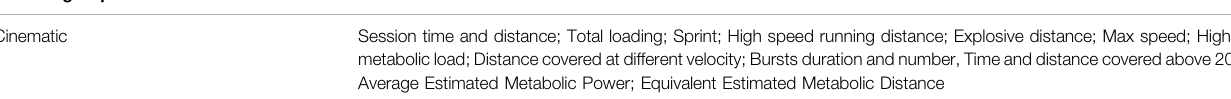
TABLE 1 | Features group. Summary of all the features extracted from the GPS devices. Feature